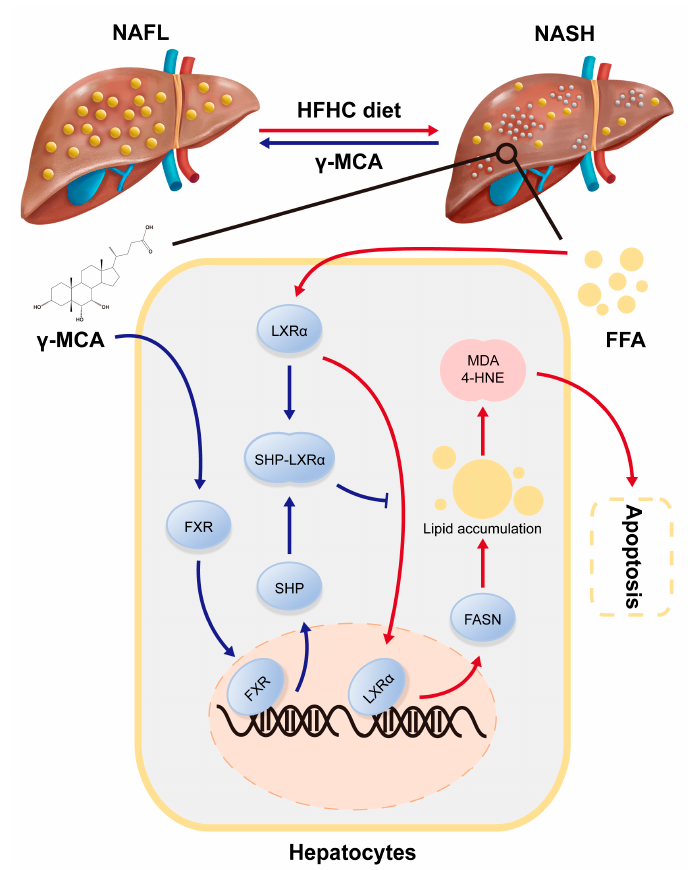
Figure 7. Schematic model depicting the inhibitory effect of γ -MCA on NASH via FXR/SHP/LXR α /FASN signaling. The γ -MCA-activated FXR upregulates the expression of SHP, which dimerizes LXR α to transcriptionally inhibit its target genes (e.g., FASN). Inhibition of FASN reduces de novo lipogenesis in response to FFA, and then abolishes the lipid accumulation in hepatocytes. Steatotic attenuation leads to decreased lipid peroxidative products (e.g., MDA, 4-HNE) and the successful diminution of hepatocytic apoptosis. The apoptosis-dependent lobular inflammation is finally abrogated to prevent progress from NAFL to NASH.